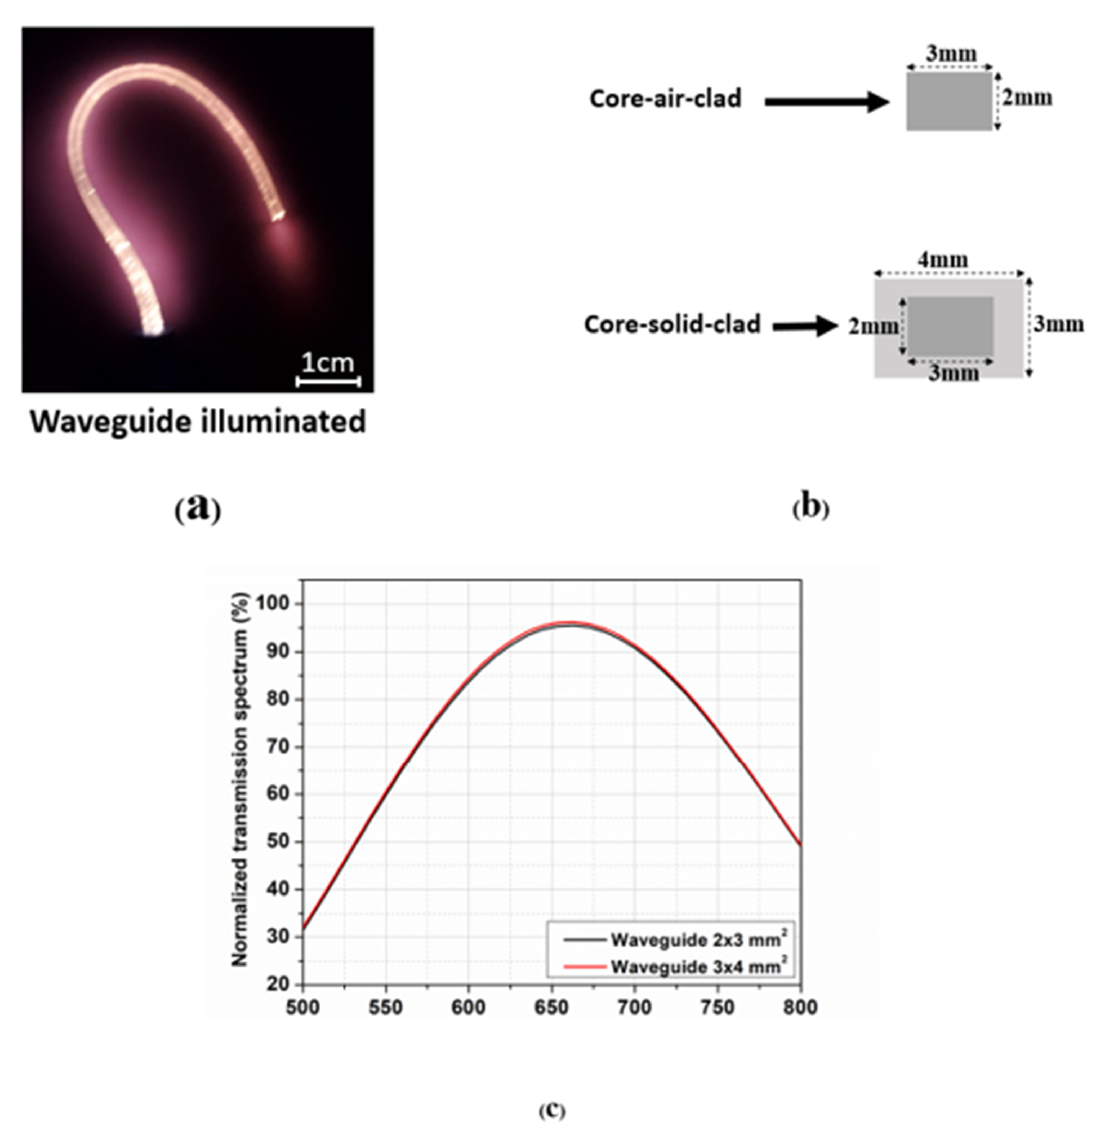
Figure 3. ( a ) Photo of a waveguide illuminated with white light. ( b ) Core-air-clad and core-solid- clad waveguide transverse cross-section. ( c ) Normalized transmission spectrum of the PDMS-BPh waveguides (0.1% BPh/wt.) of 20 cm length.